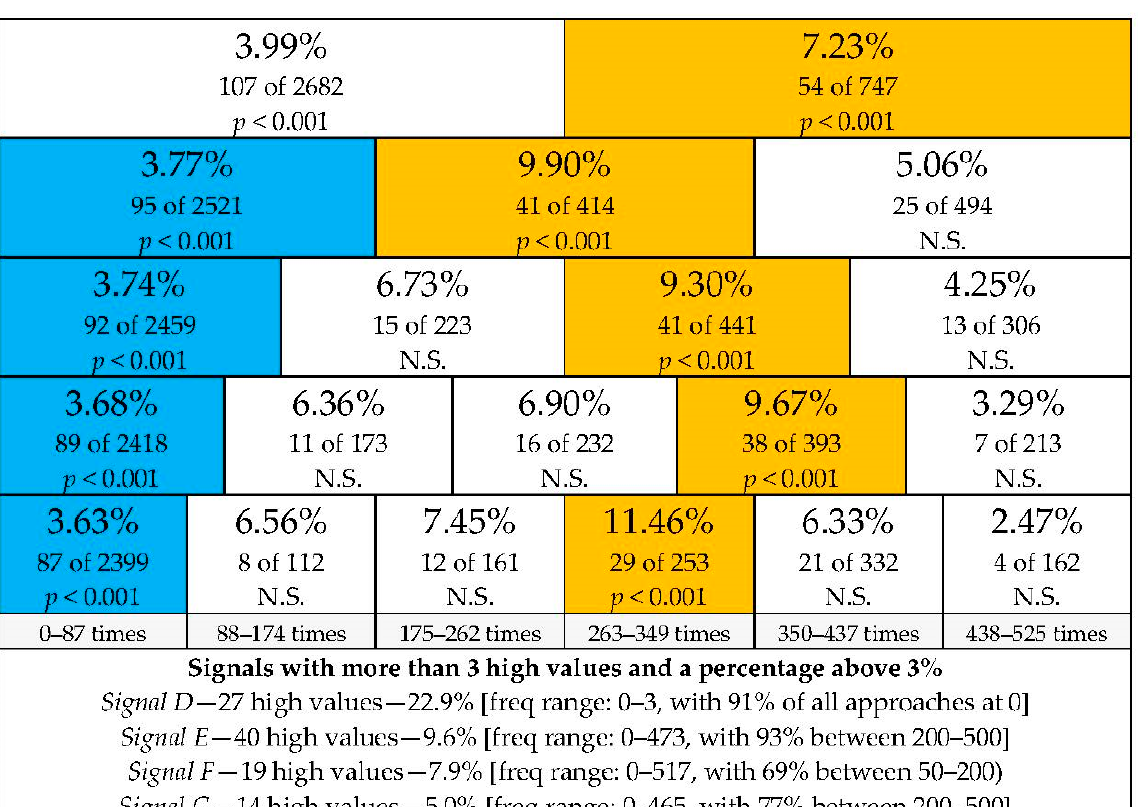
Figure 14. Entrance at yellow effect (analysis 1). This figure shows the results when the frequency in the last 14 days is split five different ways. The percentages reflect the percentage of high values in the segment. The numbers directly below indicate the number of high values and the total. Orange indicates that the percentage is significantly higher than expected and blue indicates a percentage significantly lower than expected. White color indicates no significance. The frequency ranged from 0 to 525. The mean percentage was 4.7%.